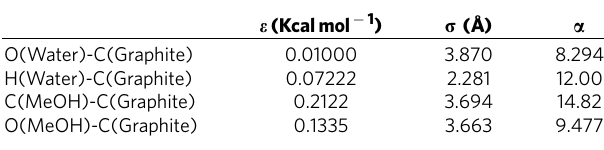
Table 1 | Best fit parameters describing the interactions between